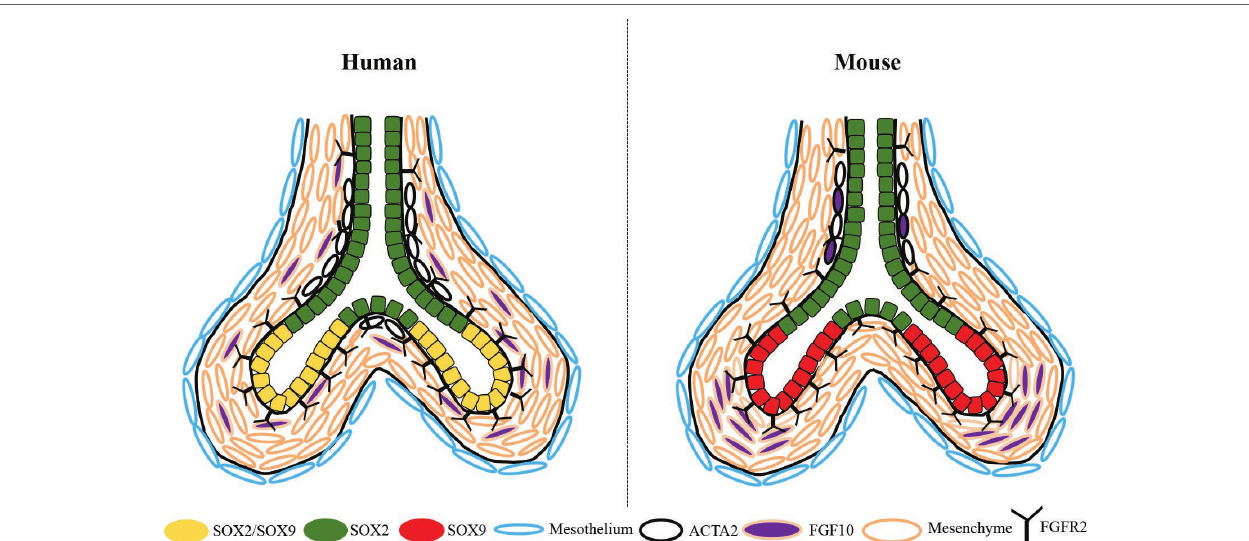
FIGURE 2 | Schematic depiction of the differential expression of SOX2, SOX9, ACTA2, and FGF10 between the developing human and mouse lung during the pseudoglandular stage. SOX2/SOX9 double positive progenitor cells are present in the distal epithelial tips of the human lung, whereas only SOX9+ cells are present in the distal tips of the mouse. ACTA2+ smooth muscle cells are found in both human and mouse surrounding the proximal airway, but extend more distally into the human lung and are closely associated with SOX2+ cells only, they are also in human at the bifurcation of the branch tips. In mouse lung, Fgf10 is highly expressed in the mesenchyme adjacent to the epithelial tips and in the smooth muscle cells surrounding the airways; whereas in humans FGF10+ cells are found dispersed throughout the mesenchyme with little expression in the smooth muscle